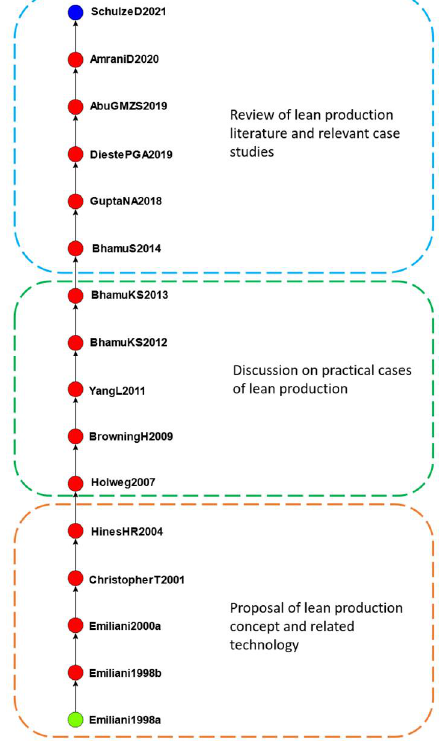
Figure 4. Global main Path.